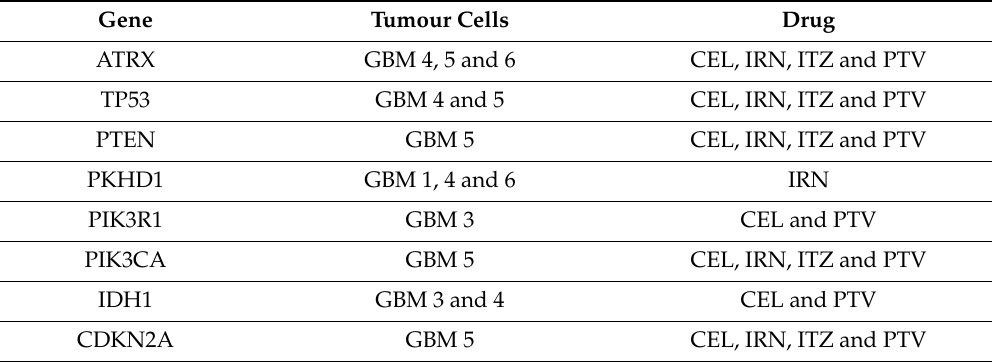
Table 3. Summary of the genes involved with the response of each